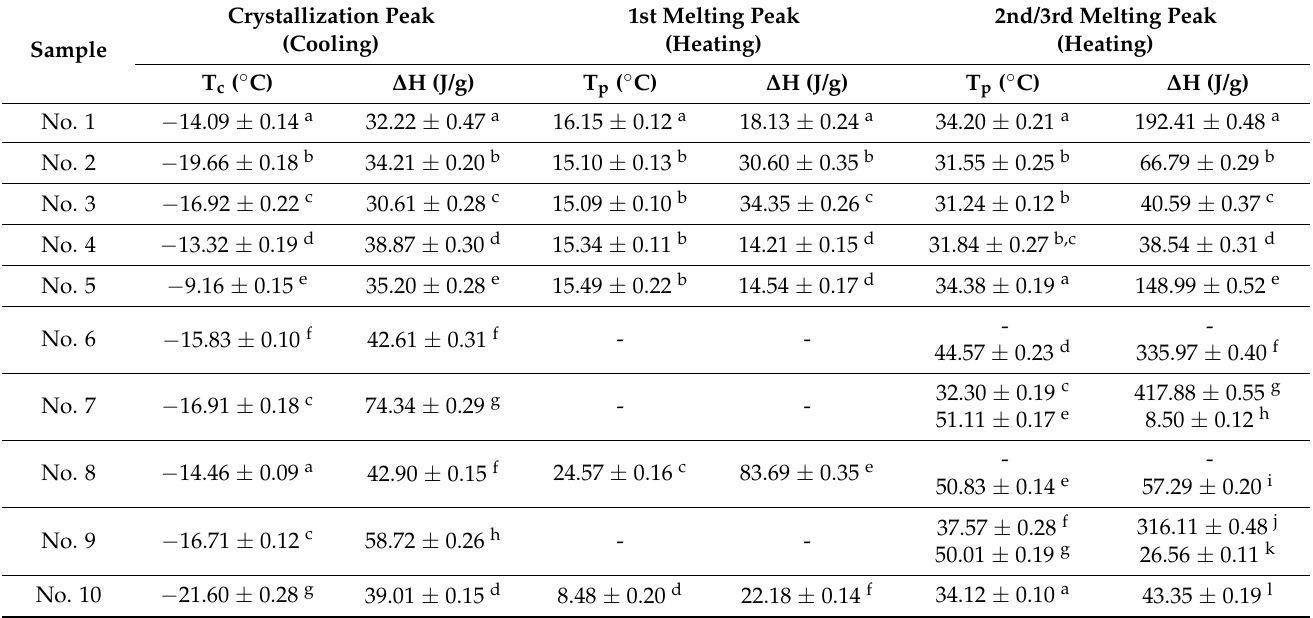
Table 2. DSC results of butters, spreadable fats and shortenings applying cooling process from +70 ◦ C to − 40 ◦ C (at cooling rate 5 ◦ C/min), and heating process from − 40 ◦ C to +70 ◦ C (at heating rate 5 ◦